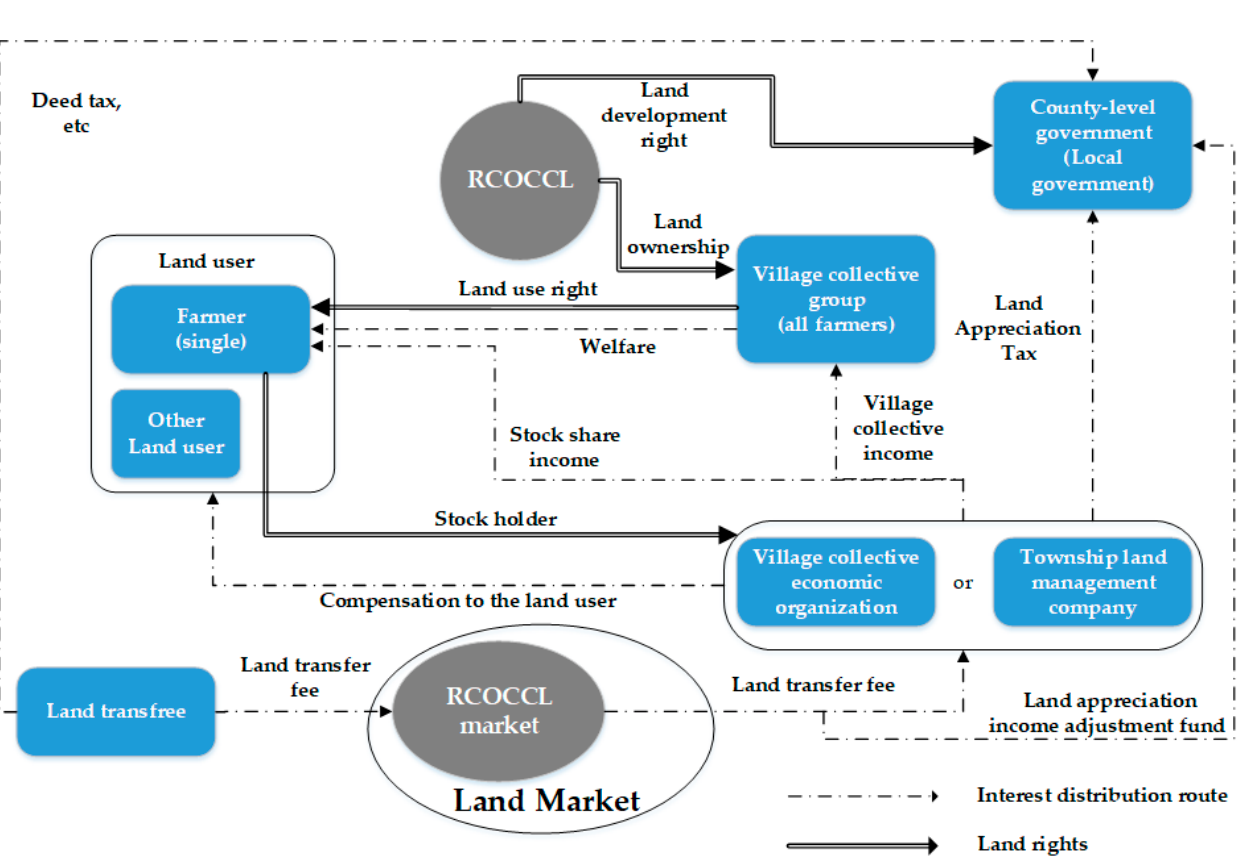
Figure 1. Interest distribution framework of RCOCCL market in pilot